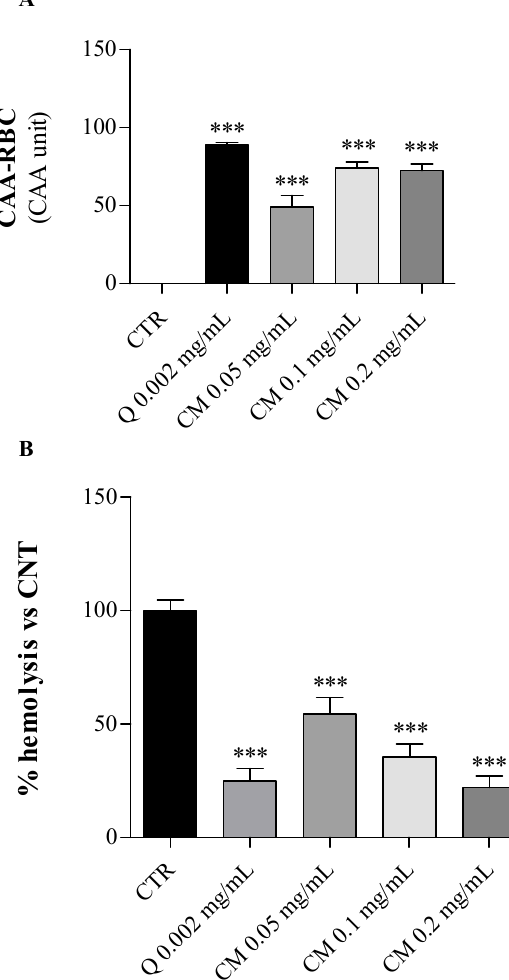
Figure 2. Effects of C. maritimum L. extract (CM) at increasing doses (0.05, 0.1 and 0.2 mg/mL) on human erythrocytes under oxidative insult. Quercetin (Q 0.002 mg/mL) was used as a reference standard. ( A ), CAA-RBC assay; ( B ), hemolysis test. Values are expressed as means ± standard deviation of 5 blood samples. *** Highly significant difference from control cells (CTR) ( p ≤ 0.001). Besides, the anti-hemolytic effect of C. maritimum was tested on human erythrocytes exposed to a strong oxidative insult (AAPH = 50 mM), which induces the erythrocyte hemolysis. Sea fennel extract pre-treatment of erythrocytes significantly lowered the AAPH-induced oxidative hemolysis ( p < 0.001) in a dose-dependent manner (Figure 2B). The percentage of hemolysis inhibition ranged from 46% to 78% (at 0.05 and 0.2 mg/mL, respectively) compared to control erythrocytes treated with AAPH only (CTR, maximum hemolysis). The highest extract concentration induced similar hemolysis inhibition to quercetin pre-treatment (75%). These results confirm the general antioxidant potential